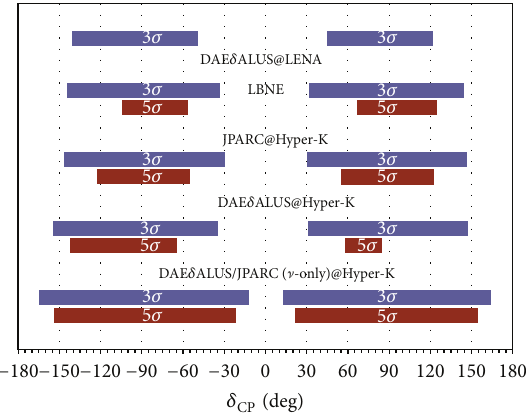
Figure 17: The 𝛿 regions where an experiment can discover CP CP = 0 ∘ or 180 ∘ at 3 𝜎 or 5 𝜎 . See Table 5 for violation by excluding 𝛿 CP the description of each